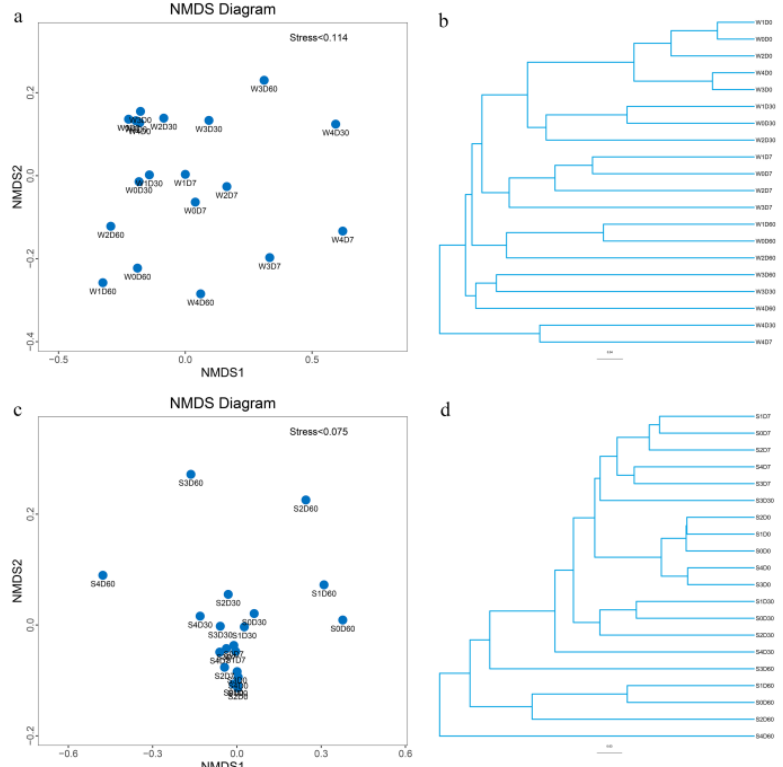
Figure 6. Nonmetric multidimensional scaling method (NMDS) analysis reveals the degree of similarity and difference of bacteria between different samples in an aquatic microcosm model. W, water; S, sediments. ( a ) The results of the NMDS analysis of water samples; ( b ) The results of the UPGMA analysis of water samples; ( c ) The results of the NMDS analysis of sediment samples. ( d ) The results of the UPGMA analysis of sediment